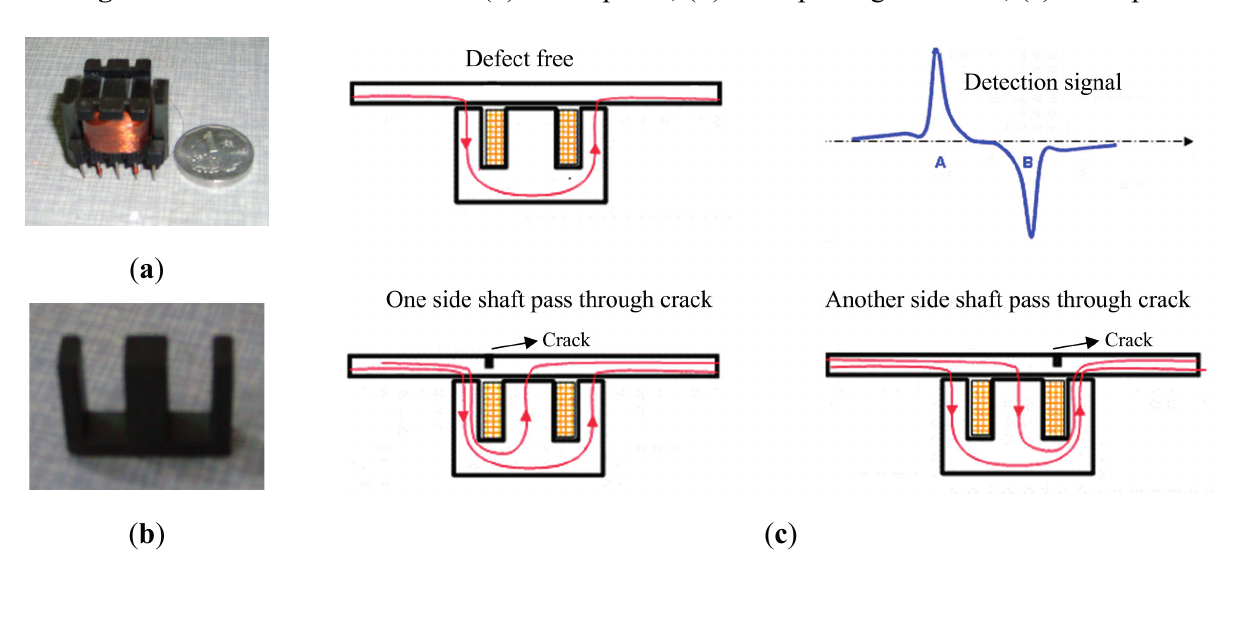
Figure 10. Self-differential mode ( a ) Pick-up coil; ( b ) E-shape magnetic core; ( c )